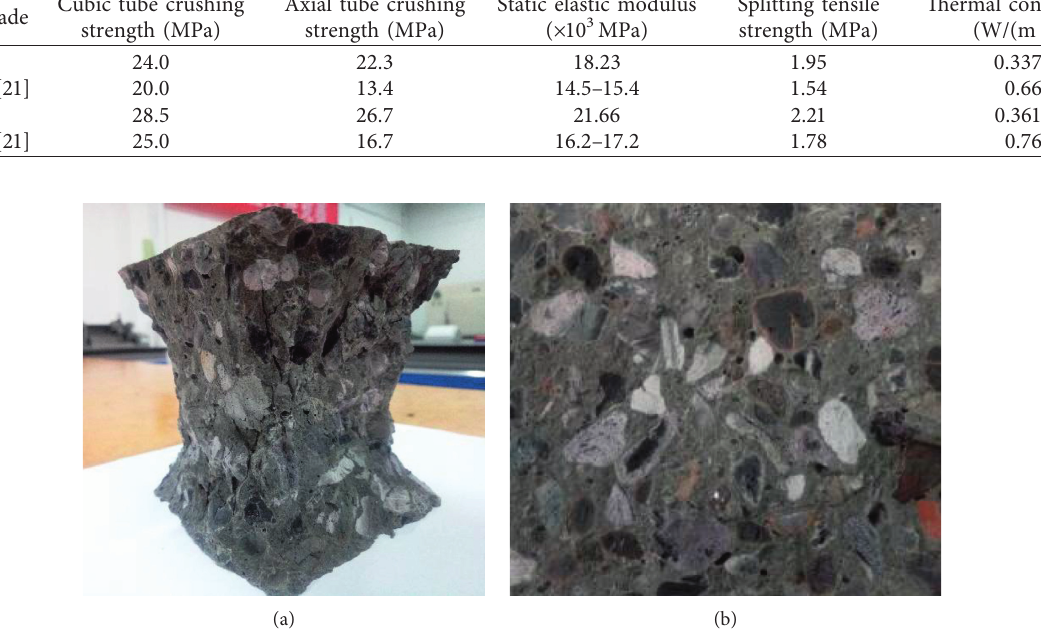
Table 14: Main physical and mechanical properties of desert sand ceramsite lightweight aggregate concrete. Strength grade